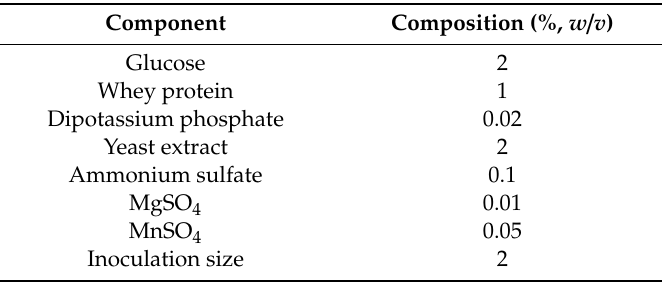
Table 2. The optimized medium condition for kefir fermentation.